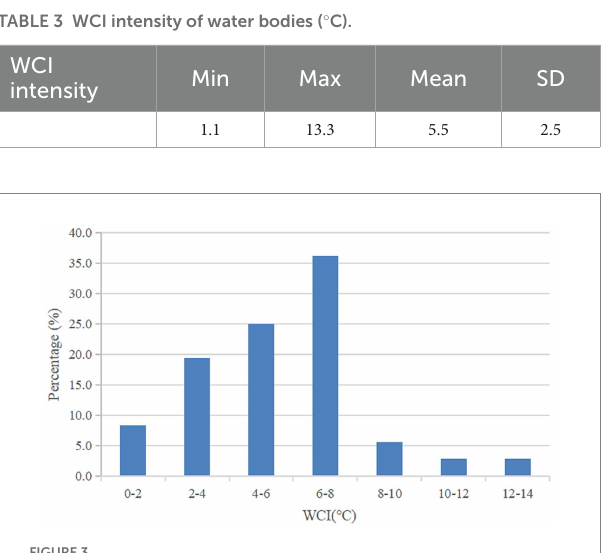
FIGURE 3 Number proportion of water bodies with different WCI